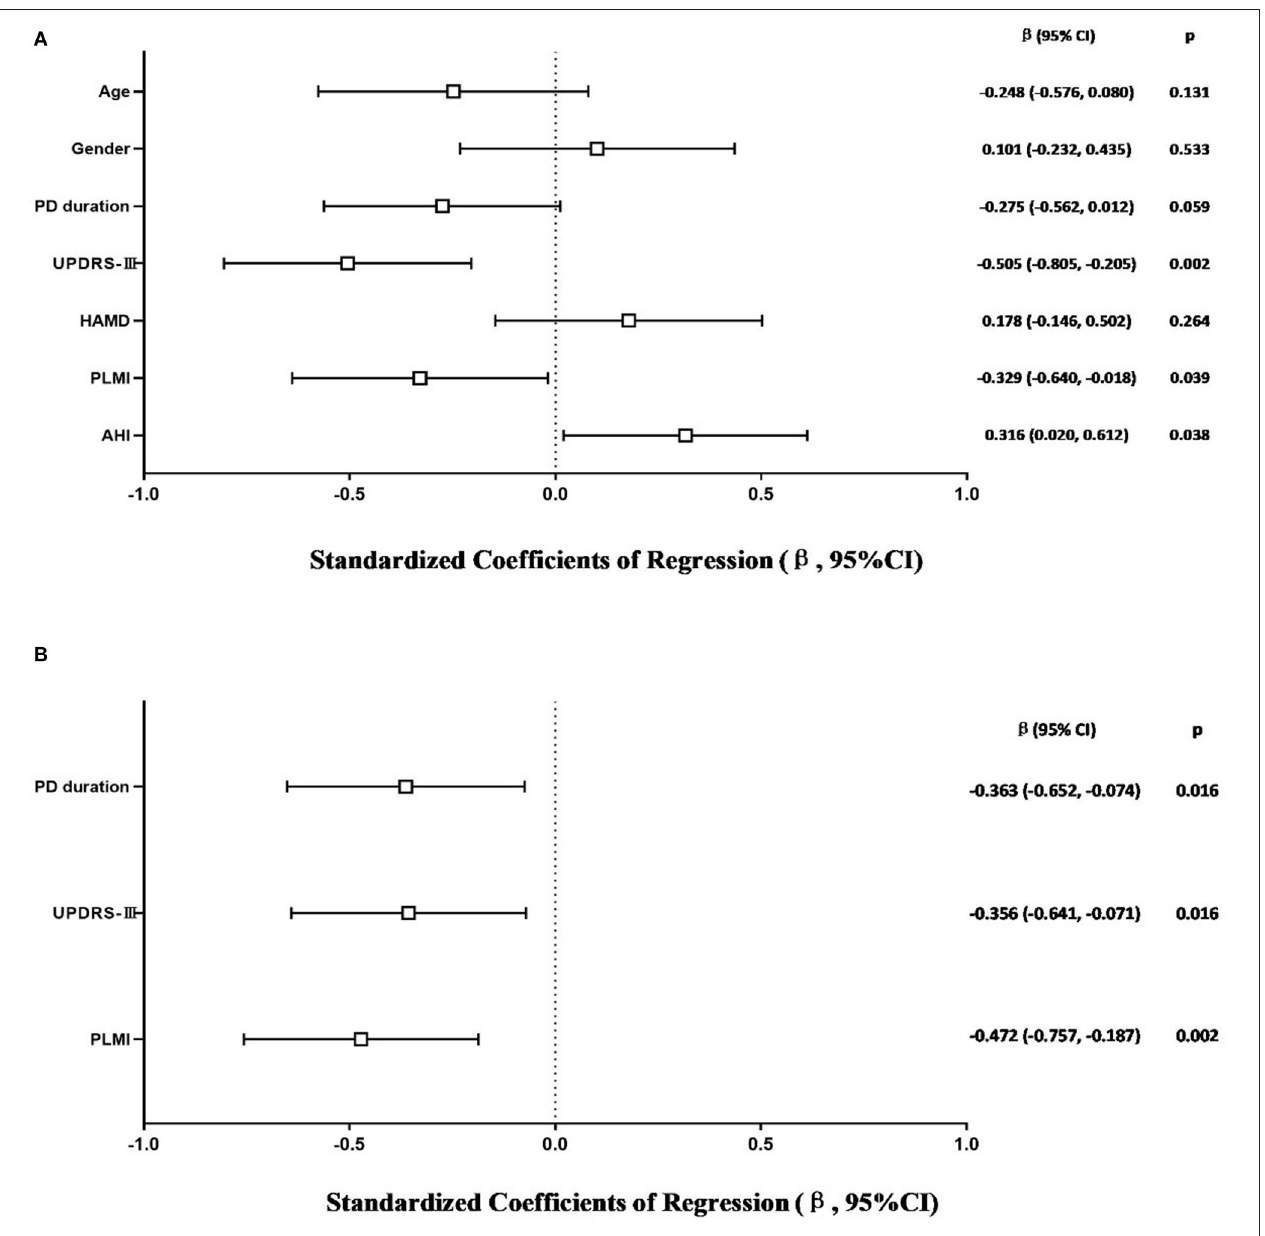
FIGURE 2 | Multiple linear regression analysis of sleep efficiency in PD-RLS patients. The squares are the standardized regression coefficients ( β , the change in terms of SDs in the dependent variable that results from a change of 1 SD in an independent variable), and the error bars indicate the 95% CI of β . The gender variant was coded as a dummy variable: male was coded 0, and 1 was used for female. PD, Parkinson’s disease; RLS, restless legs syndrome; UPDRS-III, Unified Parkinson Disease Rating Scale Part III; HAMD, Hamilton Depression Rating Scale; PLMI, periodic limb movement index; AHI, apnea–hypopnea index. (A) Risk factors of sleep efficiency in PD-RLS patients. All-factors regression (R 2 = 0.701, p = 0.001). (B) Stepwise regression (Age- and gender-adjusted, R 2 = 0.577, p <